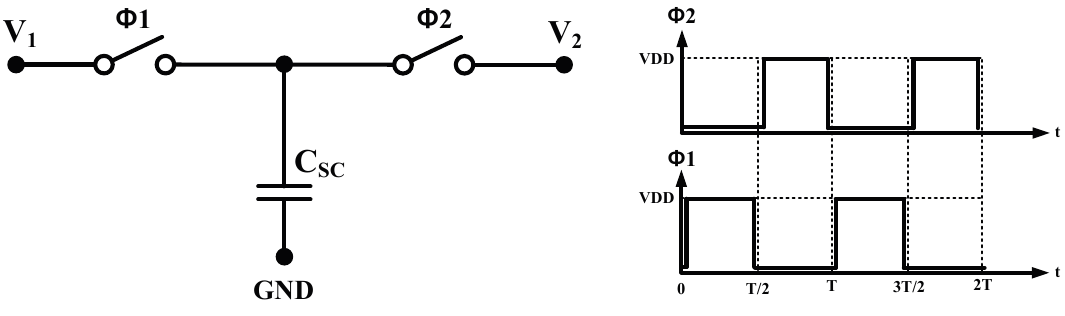
Figure 4. Schematic of the two-stage capacitively coupled chopper instrumentation amplifier (CCIA).